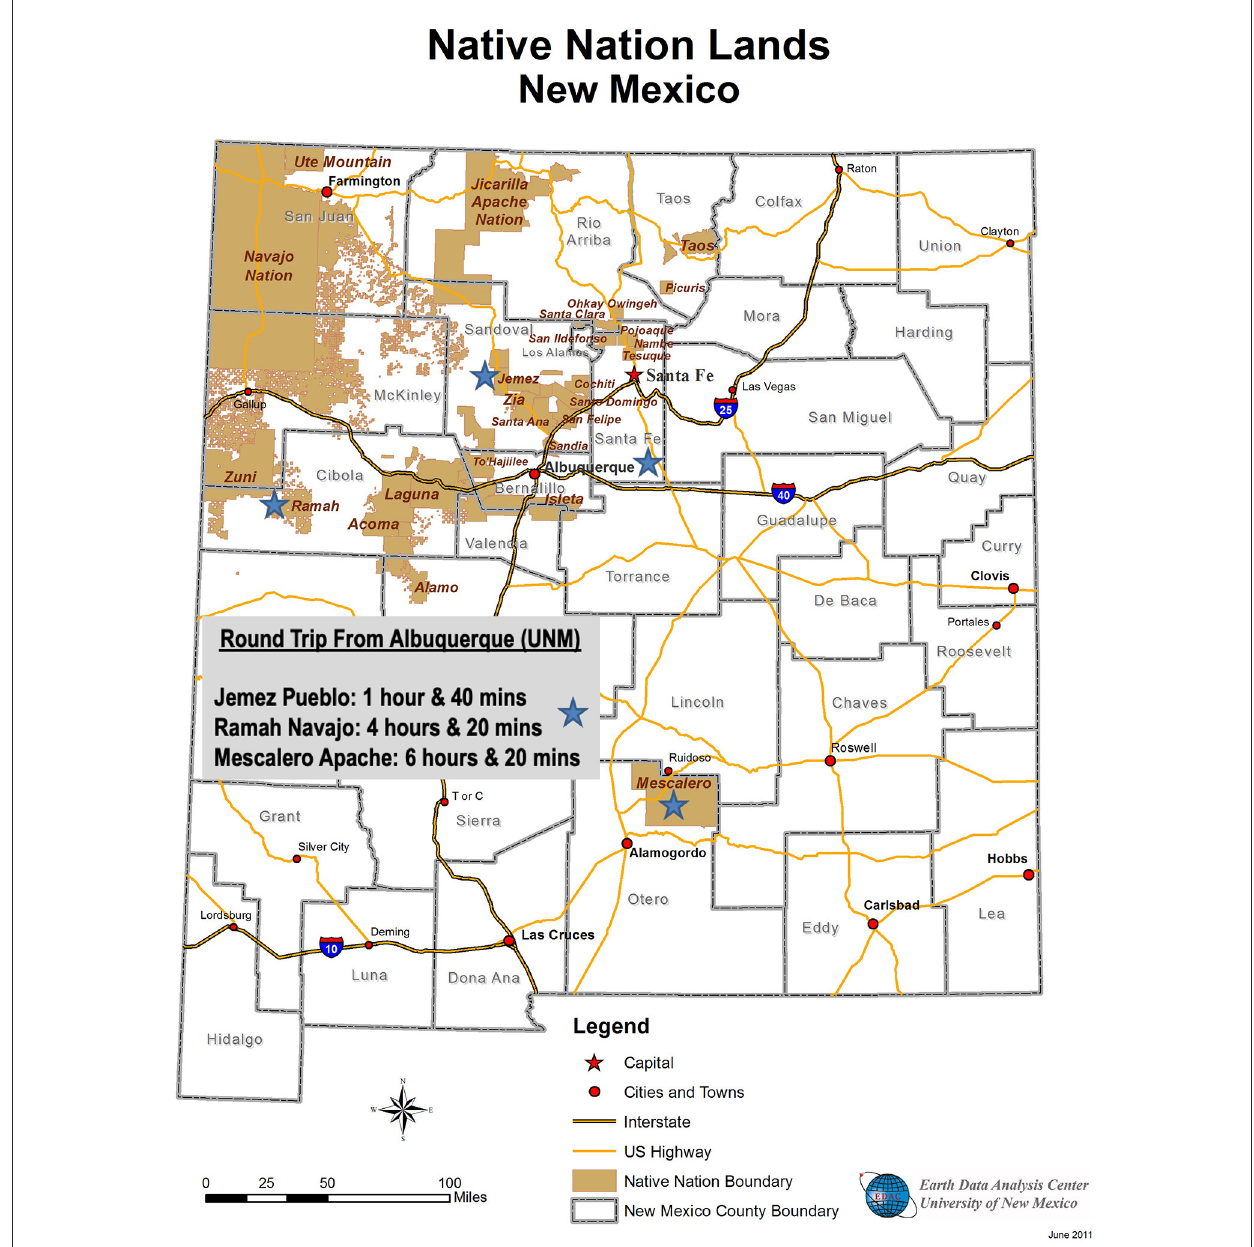
FIGURE1 Map of New Mexico tribes and location of three tribal community